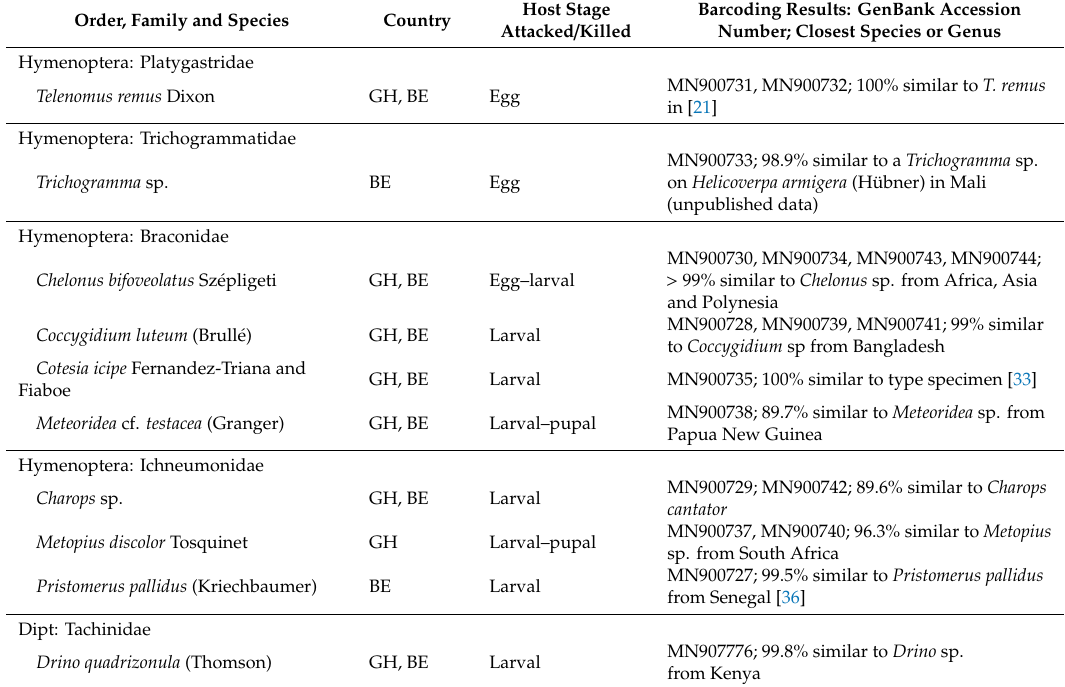
Table 1. Parasitoid species emerged from S. frugiperda eggs and larvae collected in maize farms in Ghana (GH) and Benin